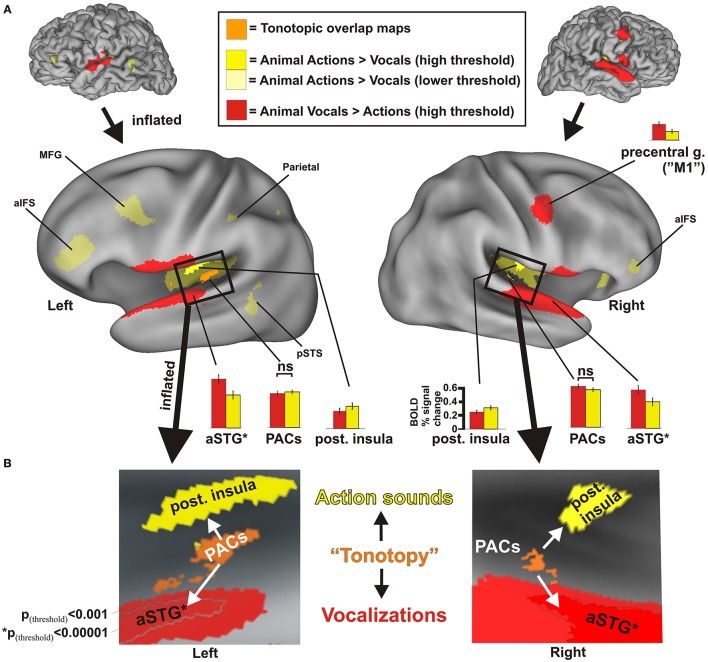
Results from group-averaged fMRI data (n = 17) revealing divergent cortical pathways for processing animal action sounds (yellow) vs. animal vocalizations (red), both relative to processing silent events (solid yellow hues at high threshold settings: p(uncorr) < 0.001, alpha corrected for multiple comparisons to p(corr) < 0.05; transparent yellow hues at a lower threshold setting p(uncorr) < 0.05, p(corr) < 0.05). (A) Data are illustrated on fiducial and inflated PALS atlas surface models. For comparison, functionally defined estimates of tonotopically organized primary auditory cortices (PACs, orange cortices) are also mapped (refer to Methods). Histograms indicate the BOLD percent signal changes (average ± SEM) in response to each sound category relative to silent events for various regions of interest, all of which were significant at p(corr) < 0.001 except for the PAC regions. aIFS = anterior inferior frontal sulcus, aSTG = anterior superior temporal gyrus, M1 = primary motor cortex, MFG = medial frontal gyrus, PACs = primary auditory cortices, pSTS = posterior superior temporal sulcus. aSTG* = foci (black outline) based on p(corr) < 0.00001 were used for generating histogram data more highly restricted to the aSTG to facilitate data interpretation. ns = not significant. (B) Insets illustrate boxed regions from the 3D models in Panel (A) after further inflation and flattening, which highlight the main findings from this study (all data at p(uncorr) < 0.001, p(corr) < 0.05). Refer to text for other details.